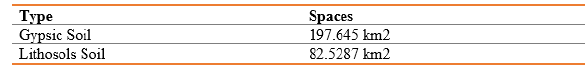
Figure 6 : Elevation map